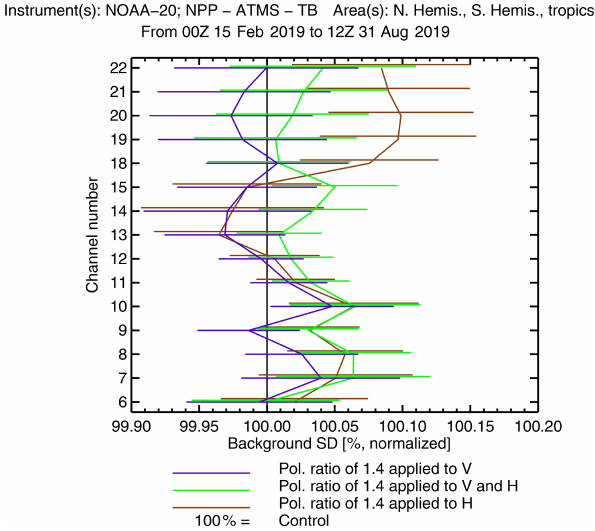
Figure 8. Normalized change in the standard deviation ( σ ) of back- ground (12h forecast) fits to independent ATMS observations with a polarization ratio ( ρ ) of 1.4, applied in different ways to the V and H channels. Error bars give the 95% confidence interval estimated using a paired-difference t test from per-cycle (every 12h) statistics, without corrections for multiple comparisons.